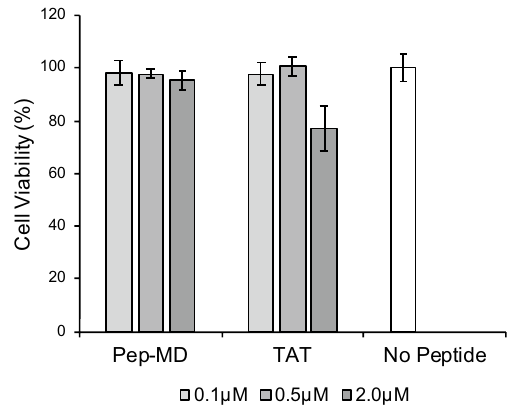
Figure 2. Cell viability test clearly indicated that Pep-MD has little toxicity at even as high as 2.0 µM, although TAT exhibited cell toxicity at 2.0 µM. Errors represent standard deviation (n = 3).